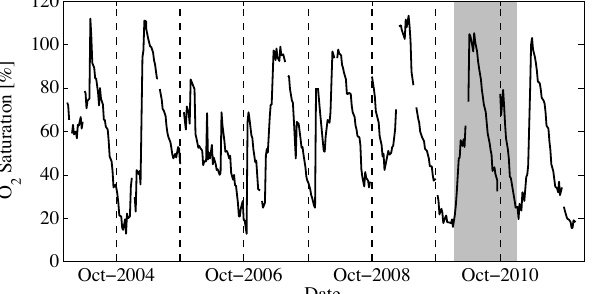
Fig. 3. Deep-water (60m) oxygen saturation time series at the Com- pass Buoy Site in Bedford Basin. Vertical dotted lines are drawn at mid-October of each year. An abrupt increase indicates a deep- water mixing event. Two distinct events are shown to occur in 2010 (shaded